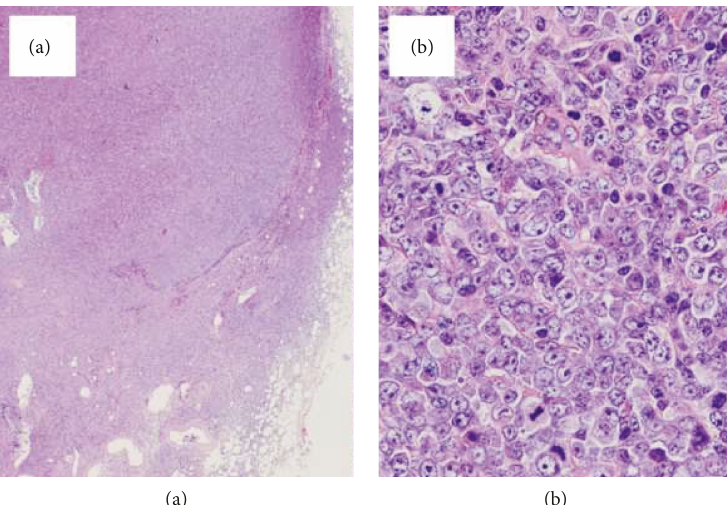
Figure 3: Histological fi ndings of the right inguinal lymph node displayed di ff use architectural e ff acement (a). Neoplastic cells were medium- to large-sized with nuclear pleomorphism (b).